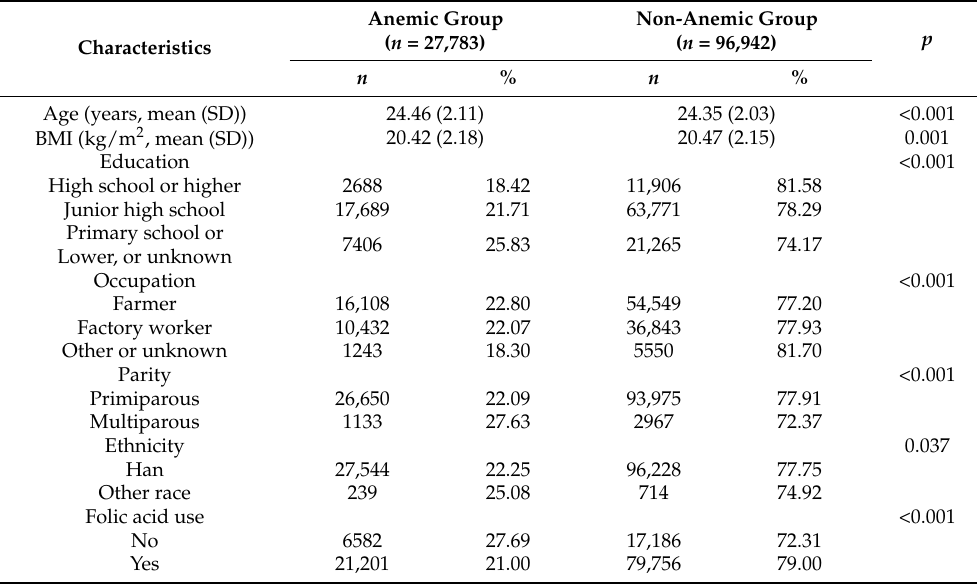
Table 1. Characteristics of Chinese women who enrolled in the pregnancy monitoring system according to preconception anemia from